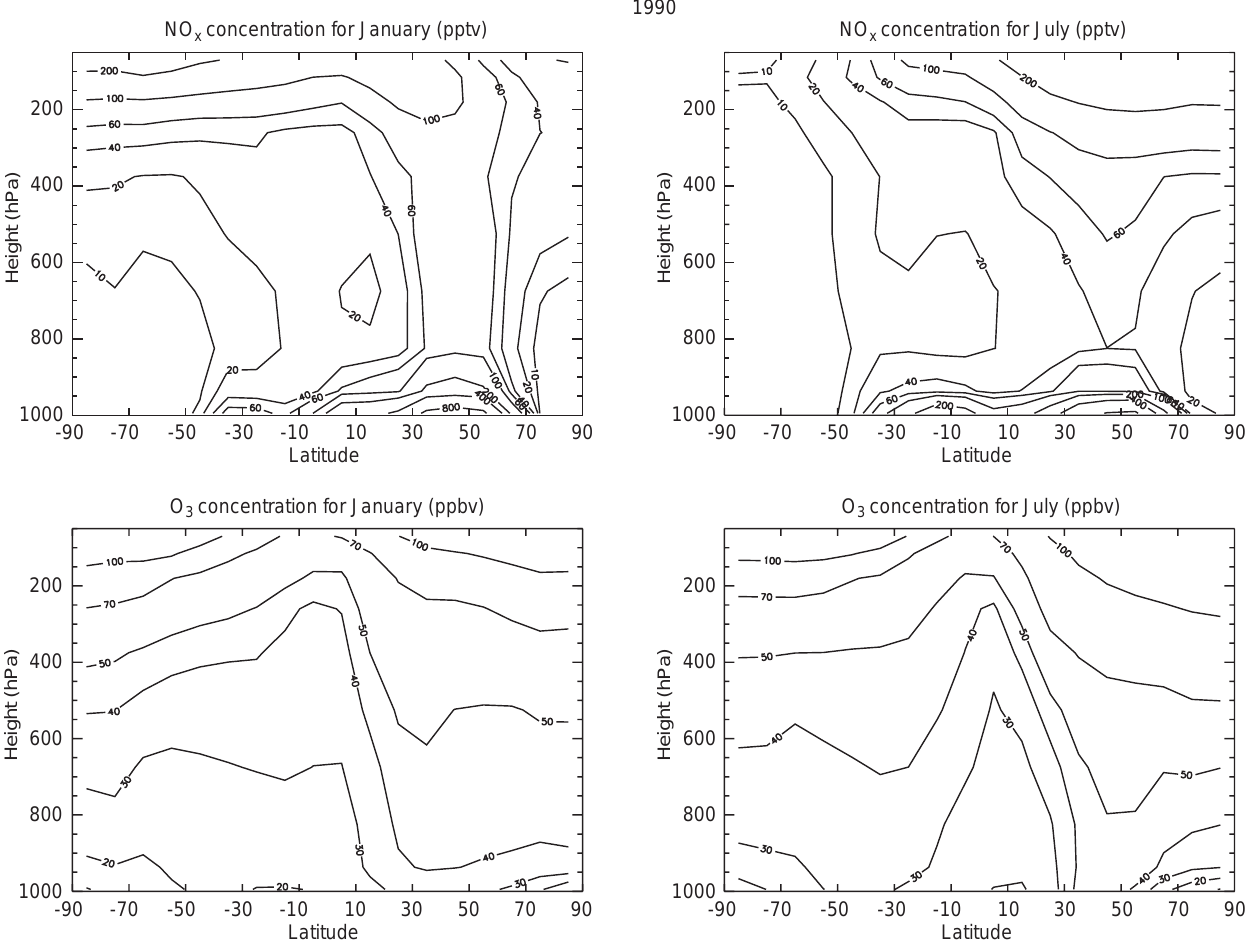
Fig. 1. Zonally-averaged NO Figures are for January